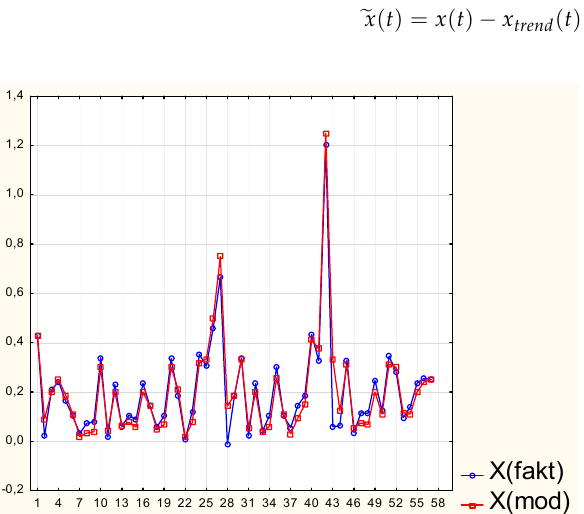
Figure 11. Diagram of series x(t) = X(t)/S(t) (blue line) and model values (red line).